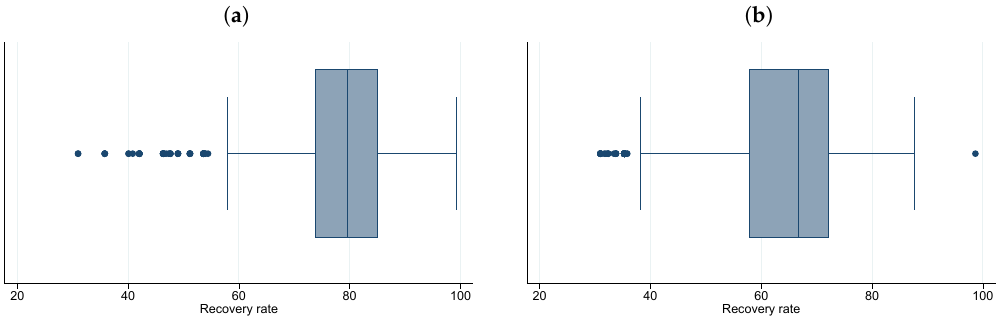
Figure 4. Considering the variable Seniority (field AS26 in the ECB template) we divide secured from unsecured loans. Panel ( a ) reports the box plot for the secured loans included in the total sample (taking into account all the pool cut-off dates), Panel ( b ) shows the box plot for unsecured loans. It is clear that banks expect to recover more from secured loans compared to unsecured